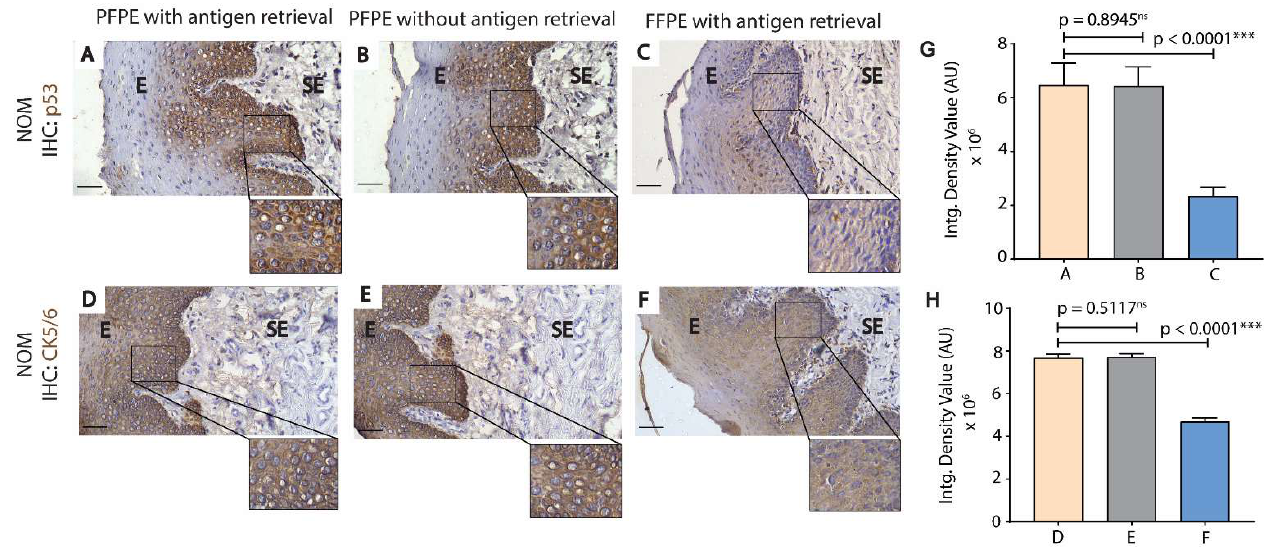
Figure 3. Heat-induced antigen retrieval is not essential for PFPE-NOM tissues. Immunohistochemistry with antibodies against p53 ( A – C ; upper panel) and CK5/6 ( D , E ; lower panel) was performed on PFPE-NOM ( A , B , D , E ) and FFPE-NOM ( C , F ) tissue sections. Parallel tissue sections of PFPE-NOM samples were subjected to primary antibody (p53 or CK5/6) incubation with a prior antigen retrieval step ( A , D ) and without an antigen retrieval step ( B , E ). Antigen retrieval was performed on tissue sections of FFPE-NOM samples ( C , F ) before antibody (p53 or CK5/6) incubation ( C , F ). p53 immuno- staining was observed in basal and suprabasal layers of the epithelium in PFPE-NOM tissues with ( A ) or without antigen retrieval ( B ). However, the intensity of p53 immuno-staining was markedly less in FFPE-NOM tissues (corresponding integrated density value plot ( G ) for A – C ) with no or noticeably light staining of p53 in basal cells. Similarly, CK5/6 immuno-staining was observed homogenously throughout the epithelium in PFPE-NOM tissues with ( D ) and without antigen retrieval ( E ). In FFPE-NOM tissue, CK5/6 immuno-staining was observed through-out the epithelium, but with markedly less intensity than PFPE-NOM tissues (corresponding integrated density value plot ( H ) for D – F ). The incubation time for DAB chromogen was 2.5 min for p53 antibody and 1 min for CK5/6 antibody. Magnification = 20×; Scale bar = 25 µm. p < 0.0001 *** (student t -test). Abbreviations: E, epithelium, SE, sub-epithelium; AR, antigen retrieval; FFPE, formalin-fixed